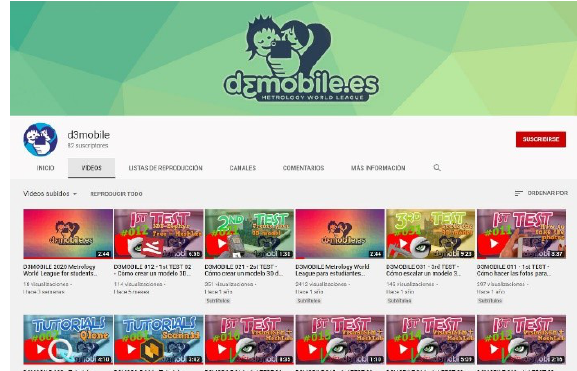
Figure 4. Audio-visual materials created for the championship.